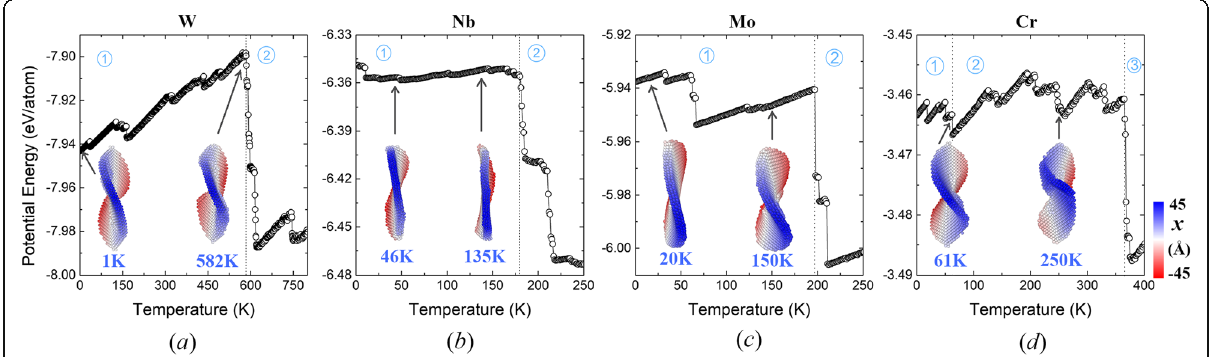
Fig. 7 Temperature evolutions of potential energies of a W, b Nb, c Mo, and d Cr nanoplates respectively. Snapshots of the representative states are shown as